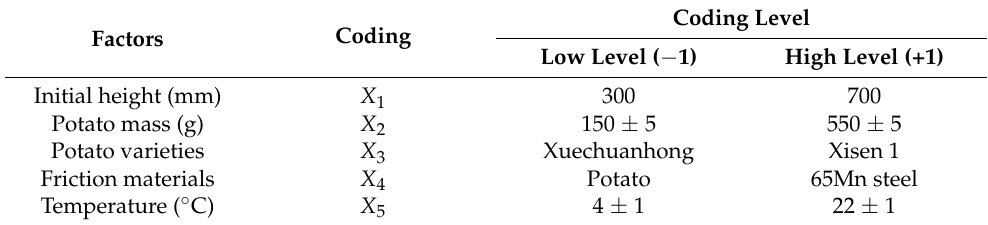
Table 1. Table of factorial test factors and levels.